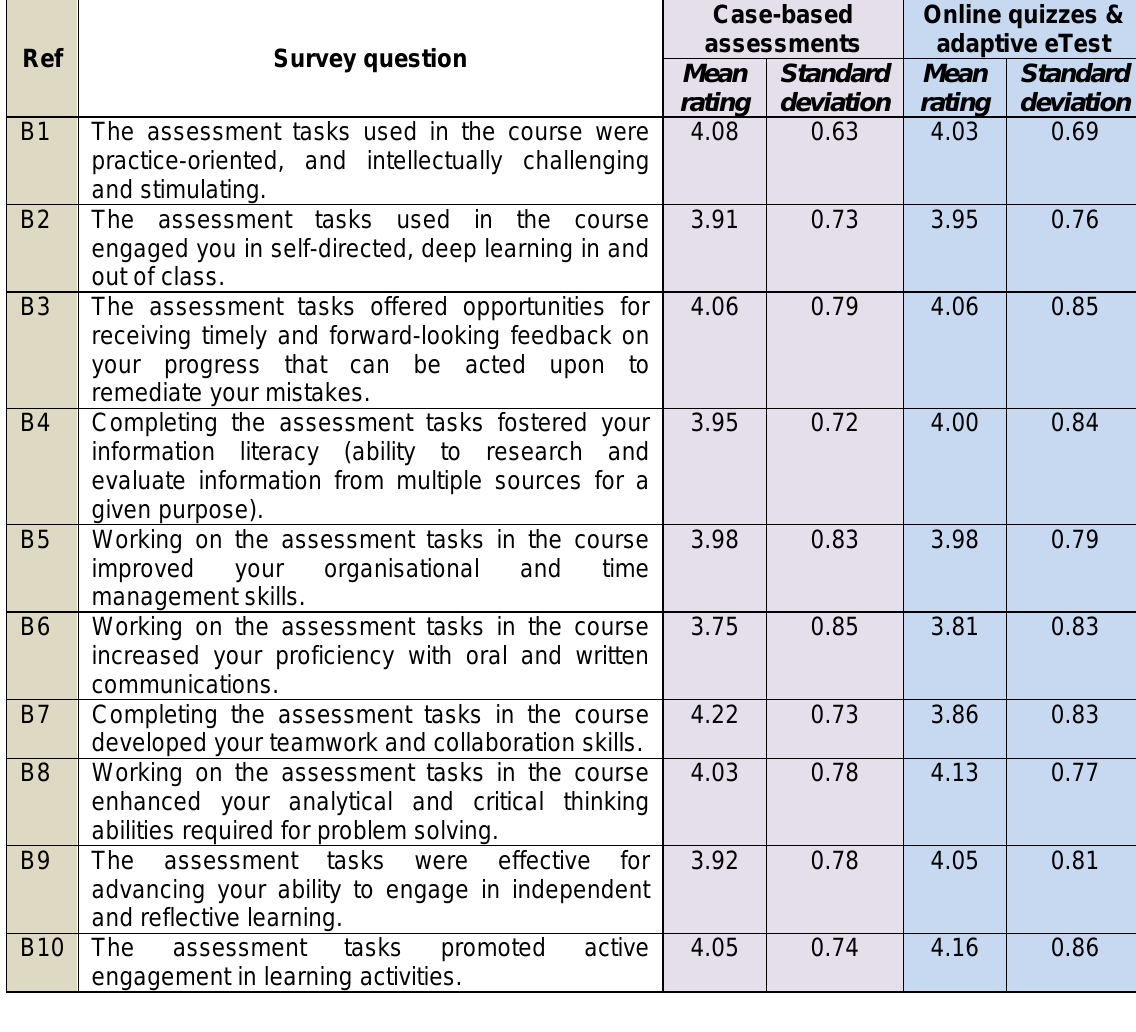
Table 3: Comparison of assessment methods Ref Survey question